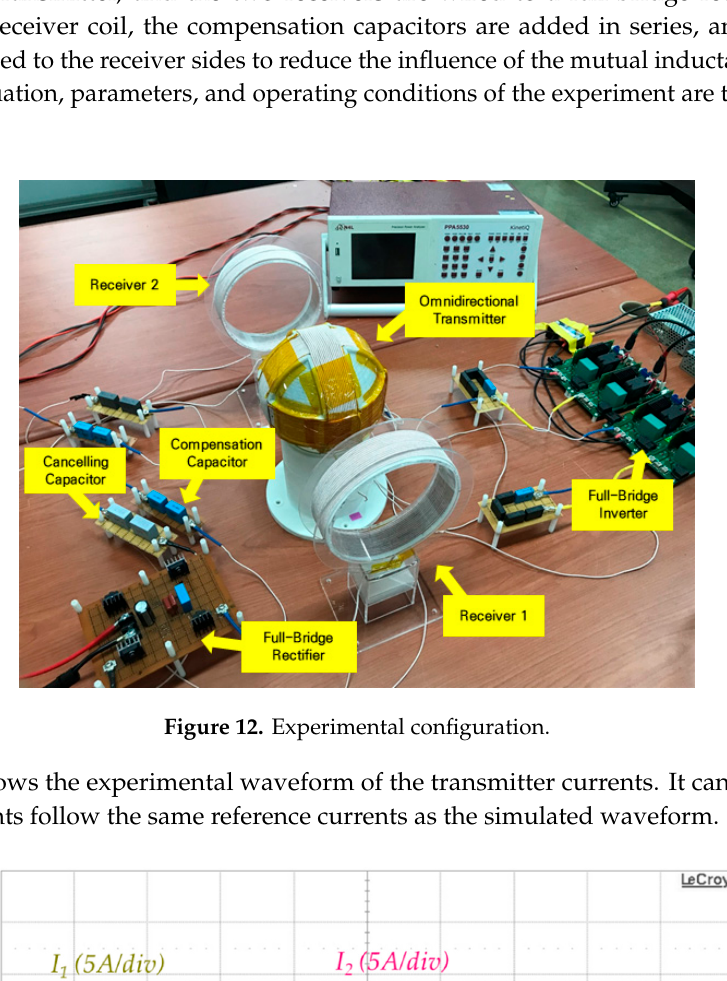
Figure 11. Simulated result: power transfer efficiency (PTE).